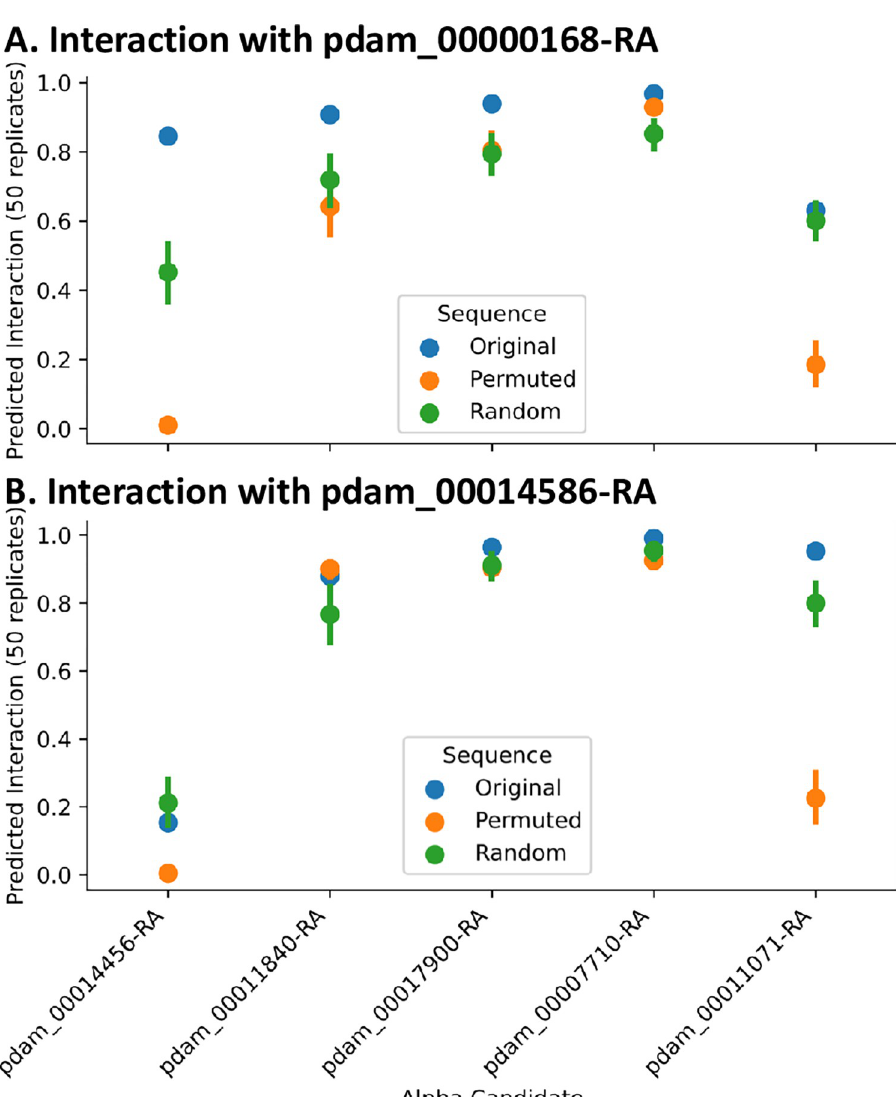
Fig 6. Predicted interaction of candidate alpha proteins with beta candidate proteins 00168 (A), 14586 (B). Original : Original predicted probability. Permuted : Average predicted probability of 50 samples with 25 beta-binding residues randomly perturbed. Random : Average predicted probability of 50 samples with 25 randomly chosen residues randomly perturbed.